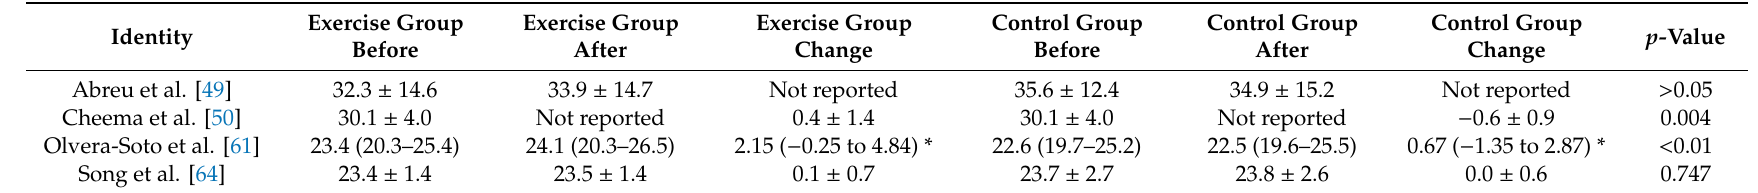
Table 3. Results on